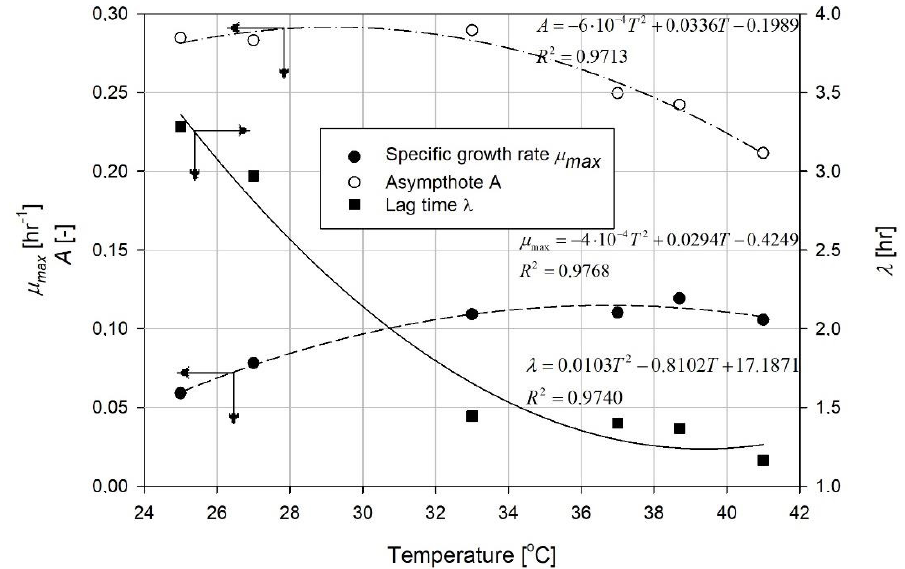
Figure 5. Changes of growth parameters with the process temperature. The approximations were